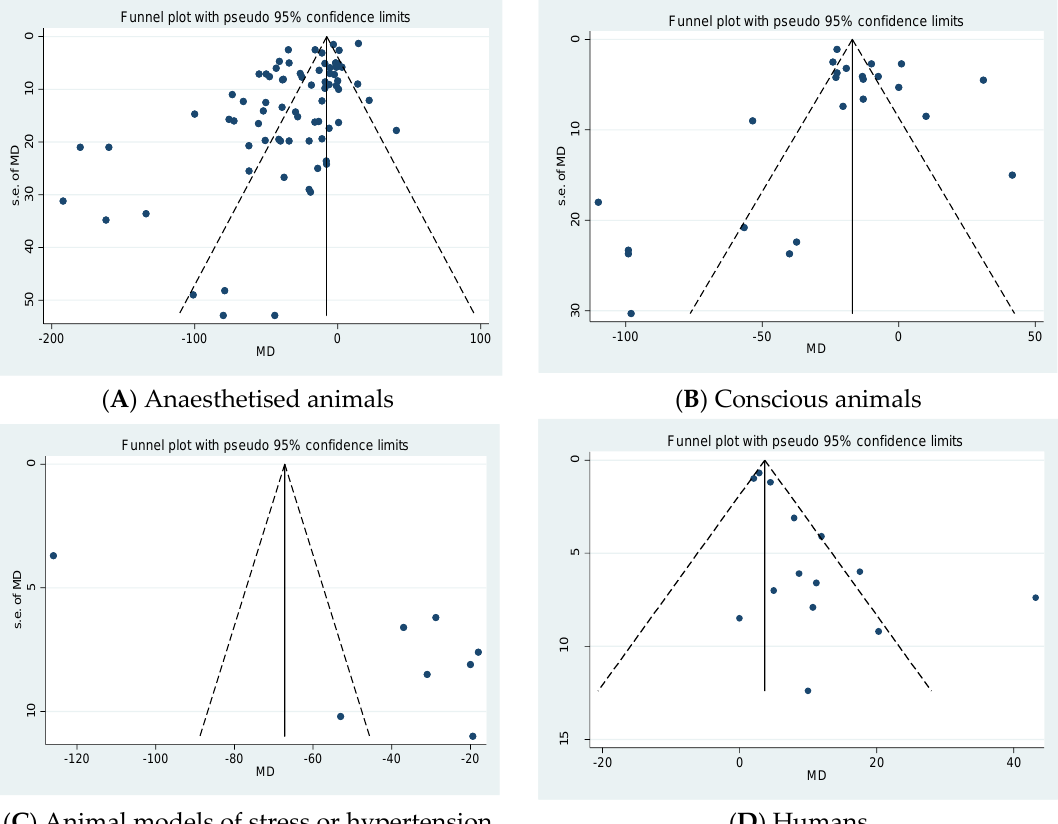
Figure A1. Funnel plots for each outcome evaluating the publication bias. The standard error (SE) of the mean difference (MD) in haemodynamics (MD, y axis) for each study is plotted against its effect size ( horizontal axis). There was significant bias in conscious animals ( B ) ( p = 0.001), animal models of stress or hypertension ( C ) ( p = 0.001), and humans ( D ) ( p < 0.0001). No significant bias in anaesthetised animals ( A ).